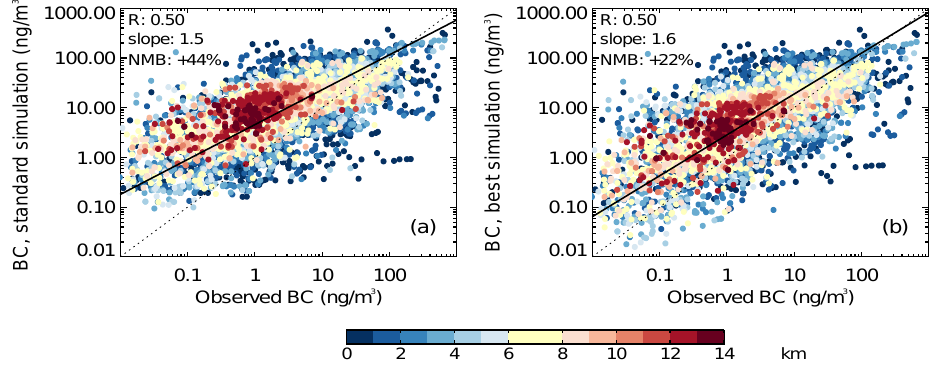
Figure 4. Point-to-point comparison of observed and simulated BC mass concentrations from the HIPPO aircraft campaign for (a) the “baseline” simulation and (b) the “best” simulation. The color bar shows the altitude of the aircraft measurements. The 1-to-1 line is shown as a dotted black line, the best-fit line is shown as a black solid line. NMB: normalized mean bias between modeled and observed